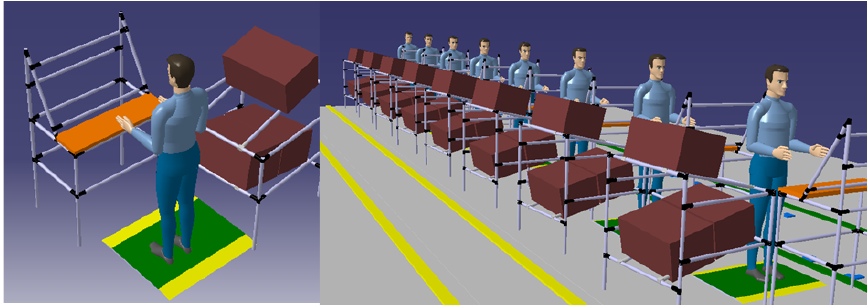
Fig. 7 – Physical System (cartoon adapted from illustrations by Lego ® ) But, if the physical event (above, left) is not an isolated scenario, then digital duplication may generate (above, right) a form of digital transformation which may be representative of a digital swarm or flock.